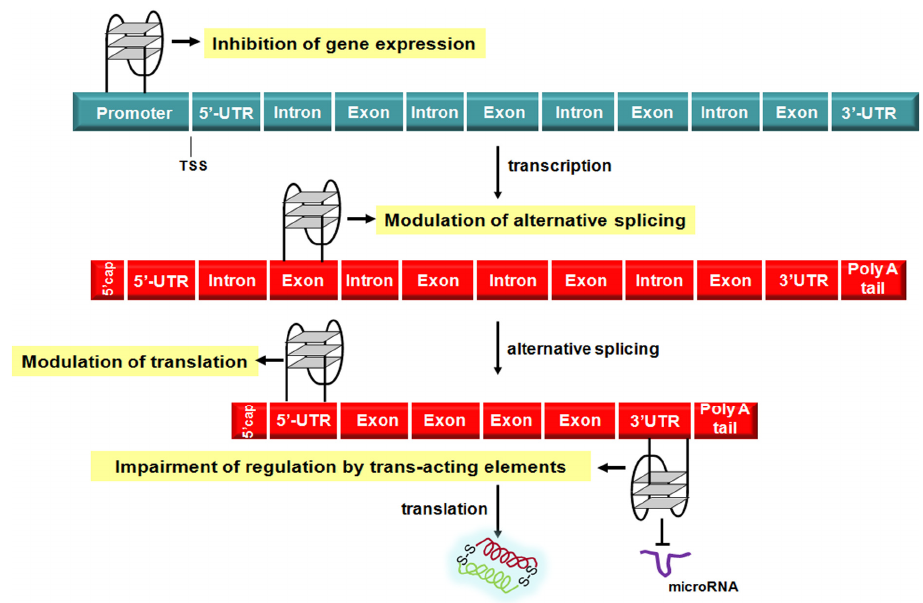
Figure 4. Schematic representation of G4-mediated regulation of the flow of genetic information. TSS: transcription start site; UTR: untranslated